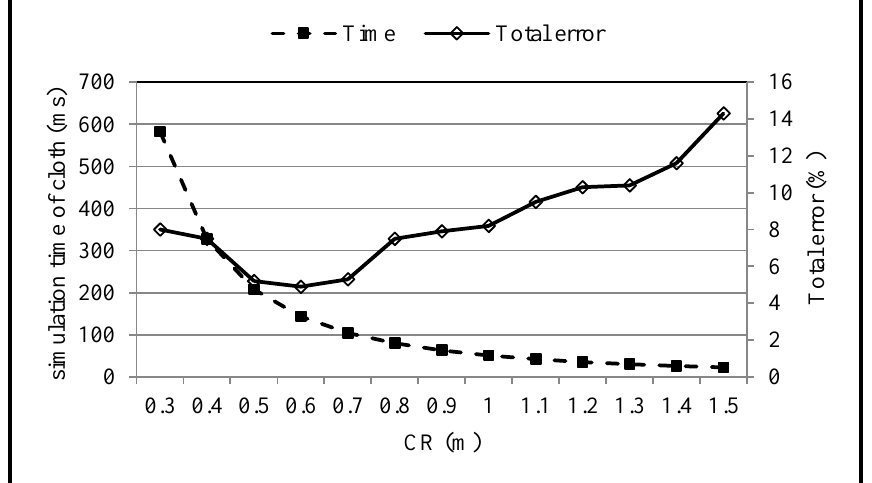
(d) Figure 21. Results of representative sample: ( a ) Overlay result of reference DTM and ground seed points (red points) produced by PTDF, ( b ) overlay result of reference DTM and ground seed points (red points) produced by the proposed algorithm, ( c ) initial provisional DTM generated from ground seed points of ( a ), ( d ) initial provisional DTM generated from ground seed points of (b). 5.2. Parameter Analysis